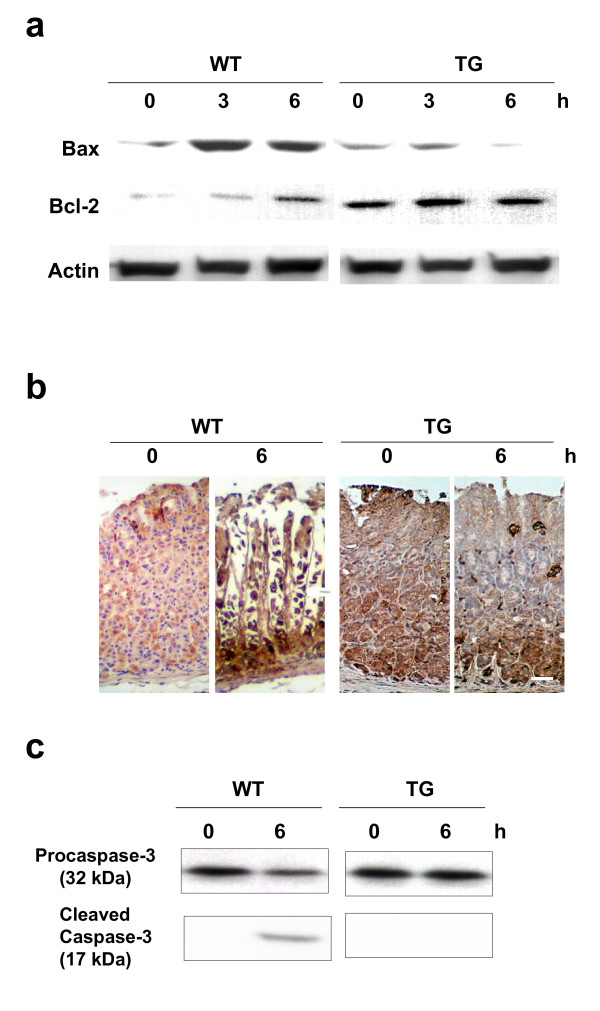
Expression of apoptosis-associated proteins. (a) Immunoblot of Bax and Bcl-2. Bax was strongly induced at the 3 h and 6 h time points in the WT mucosa, whereas it was reduced to a negligible level in the TG mucosa after ethanol injury. Bcl-2 was stably expressed similarly before and after the injury in the TG mucosa, whereas it was increased to some extent at 6 h after the injury in the WT mucosa. (b) Immunostaining of Bcl-2. Bcl-2 was not visible in the TG mucosa before the injury, but appeared along the border region of necrotic area after the injury. In contrast, Bcl-2 was constitutively induced over the TG mucosa even before the injury, and the staining was confined to the lower glandular region after the injury. Scale: 100 μm. (c) Immunoblot of caspase 3. After the injury, a 17 kDa active form of caspase 3 appeared in the WT mucosa, whereas it did not in the TG mucosa. A 32 kDa proform was unchanged both in the WT and TG mucosae.